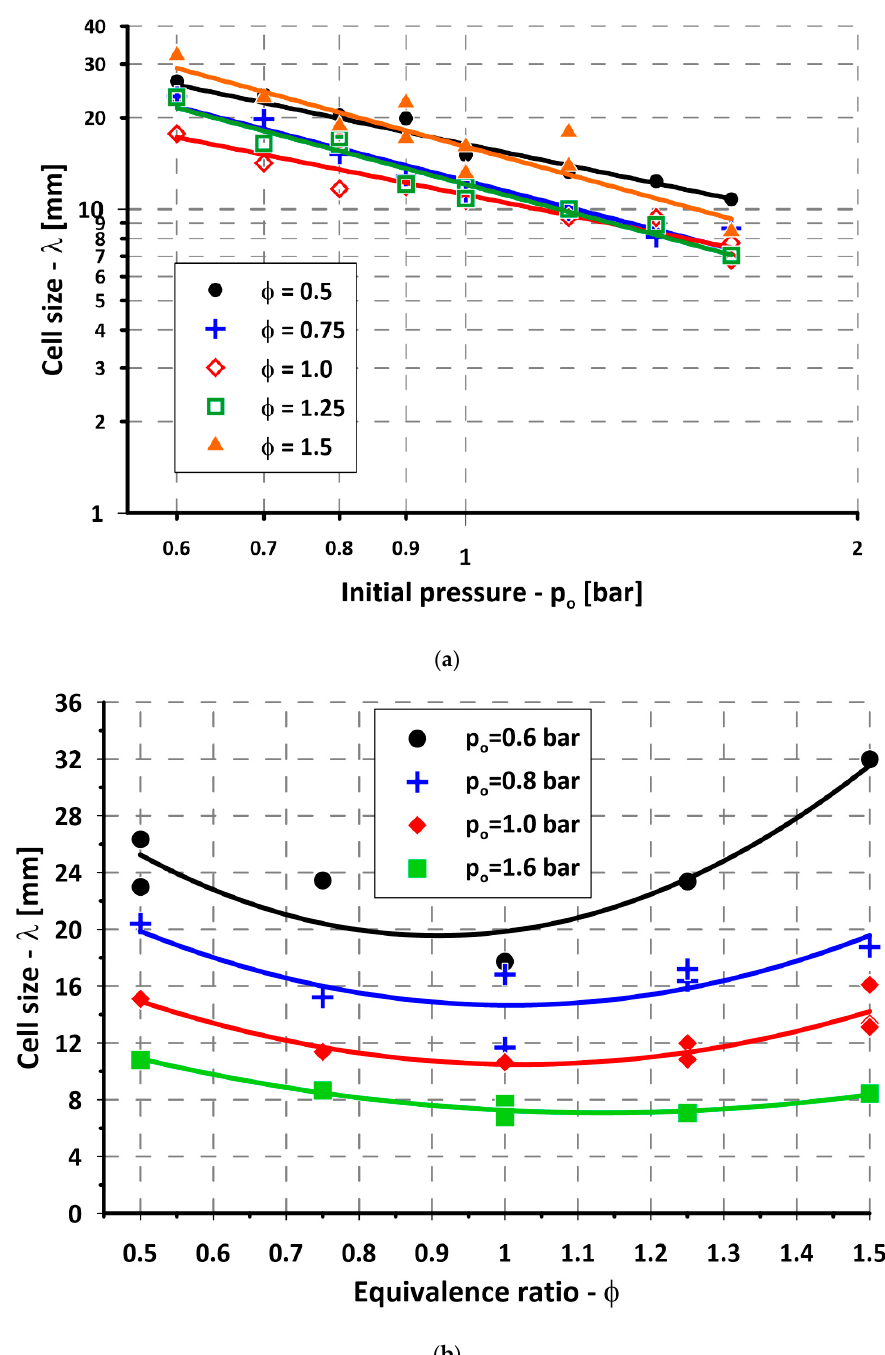
Figure 5. Average c ell size dependence on: ( a ) initial pressure p 0 ; ( b ) equivalence ratio Φ . Symbols represent experimental results, and continuous lines represent fitted power and polynomial function, respectively, in ( a ) and ( b ). Table 3. Equations and R 2 of the fitted curves from Figure 5. Figure 5a: λ = A + B * ln(p 0 )